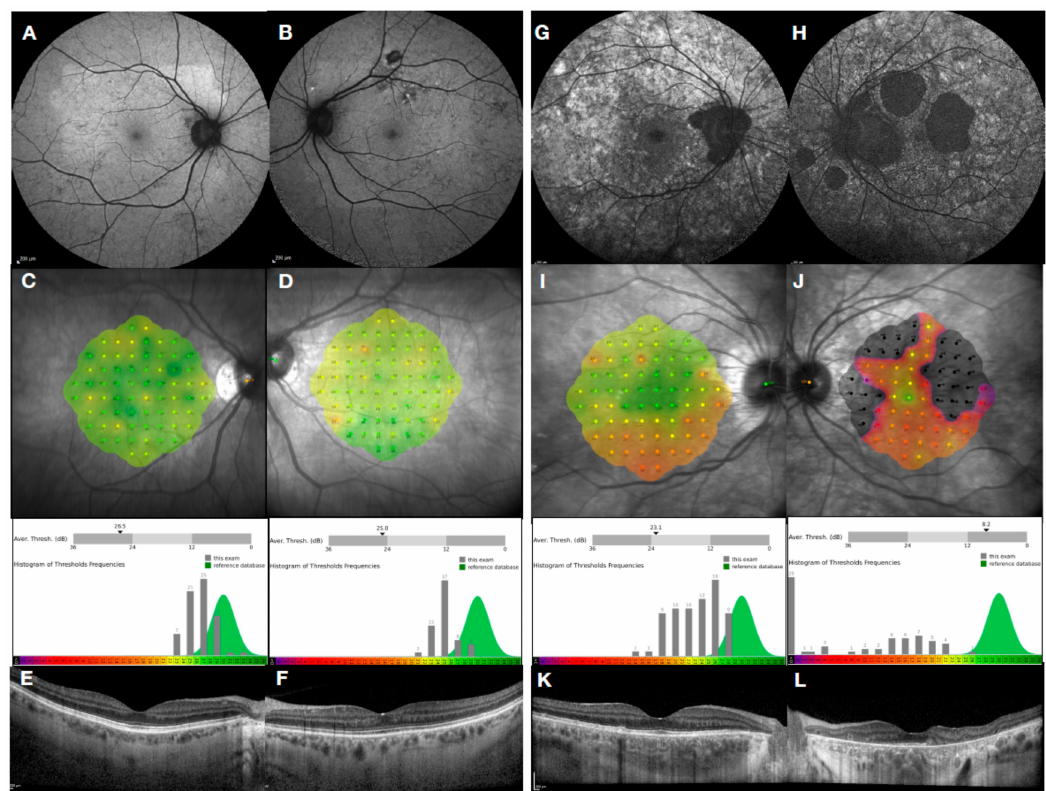
Figure 3. Retinal imaging in two female choroideremia carriers. Phenotype of an asymptomatic mild carrier with Snellen visual acuity of 6 / 5 in both eyes is shown from ( A – F ) and a carrier with a ‘geographic-pattern’ phenotype and reduced visual acuity of 6 / 7.5 in the right eye and 6 / 12 in the left eye is shown from ( G – L ). Fundus autofluorescence showing very early signs of fine ‘salt and pepper’ mottling ( A , B ) compared with coarse mottling and atrophic patches resembling geographic patterns ( G , H ). Mesopic microperimetry, MAIA CenterVue SpA, Padova, Italy showing sensitivity maps with corresponding histograms of threshold frequencies. Near-normal central retinal sensitivity is found in mild, asymptomatic carriers ( C , D ) compared to reduced retinal sensitivity in a ff ected carriers especially in the left eye of the above case ( I , J ). OCT imaging is clinically insignificant in mild, asymptomatic carriers ( E , F ) whereas some disruption of retinal pigment epithelium (RPE) and ellipsoid zone is observed in the a ff ected carrier, particularly in the left eye ( K , L